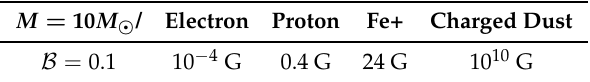
Table 2. Intensity of the magnetic field B corresponding to the magnetic parameter various types of charged particles moving in the vicinity of the black hole of mass M BH